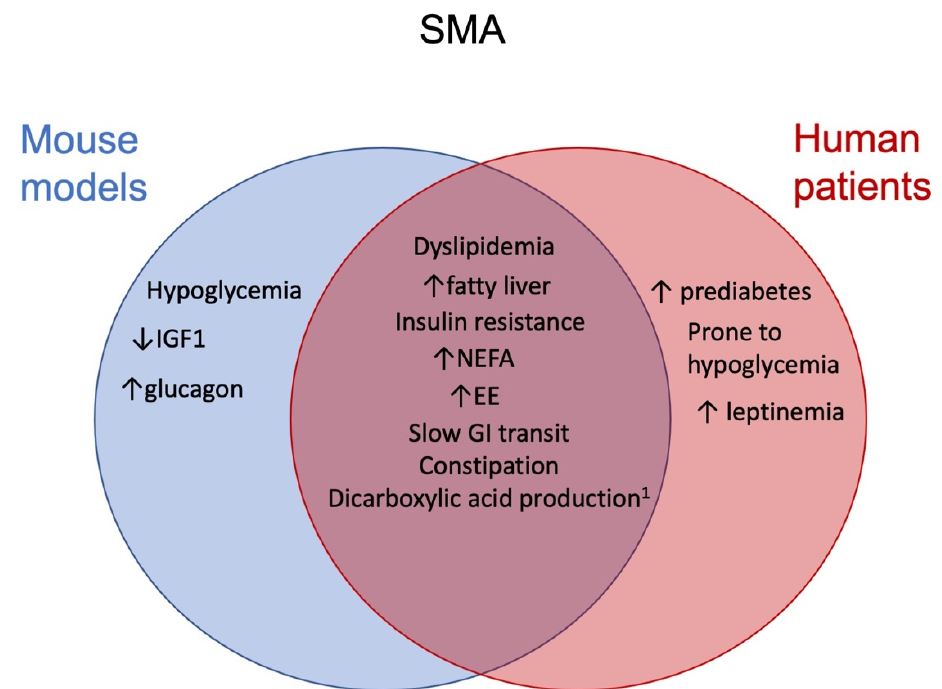
Figure 3. Commonalities between SMA mouse models and human patients. Note that findings in SMA patients may represent a subgroup rather than something found in all patients. (1) Dicarboxylic acid production is inferred by evidence of microsomal oxidation in Smn 2B/ − mouse model. EE—energy expenditure; NEFA—non-esterified fatty acids, black arrow pointing up ( ↑ )—increase, black arrow pointing down ( ↓ )—decrease.